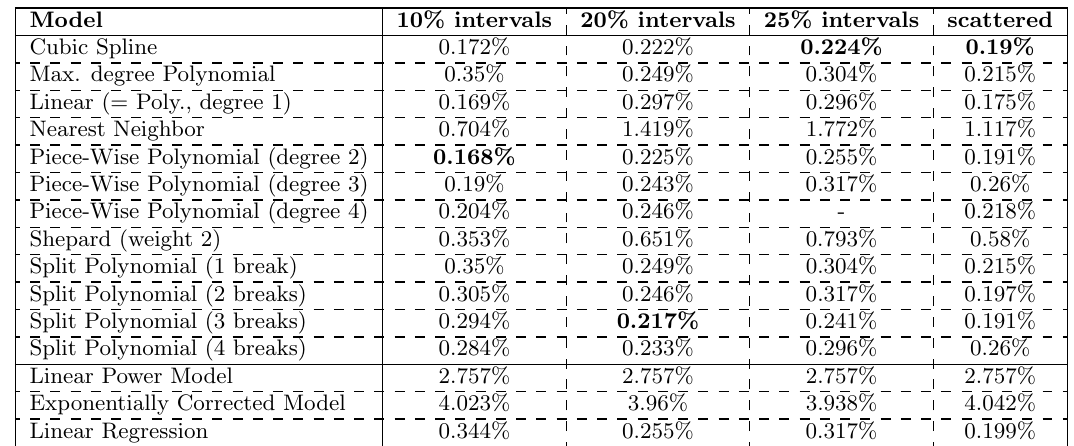
Table 1: Mean modeling errors for the power over load level function of the SSJ